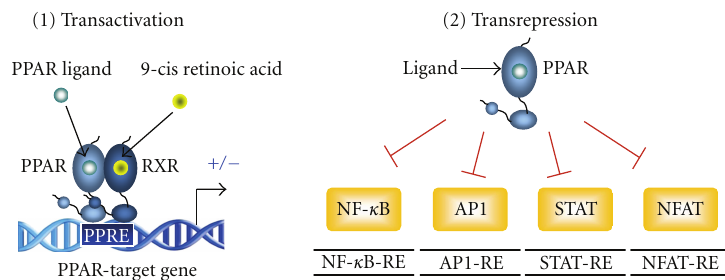
Figure 1: Molecular mechanisms of Peroxisome Proliferator-Activated Receptors (PPARs). PPARs are ligand-activated transcription factors that regulate gene expression through two mechanisms: transactivation and transrepression. In transactivation, PPAR-RXR heterodimers bind to DNA-specific sequences called peroxisome proliferator-response elements (PPREs), which are located in the promoter regions of genes involved in glucose and fatty acid metabolism. PPARs may also regulate gene expression through a DNA-independent mechanism called transrepression. Through this mechanism, PPARs inhibit the activity of several transcription factors such as Nuclear Factor- κ B, which leads to anti-inflammatory e ff ects. STAT denotes signal transducers and activators of transcription, IS-GFRE is the interferon-stimulated gene factor responsive element, and TRE is the TPA responsive element, where TPA is a phorbol